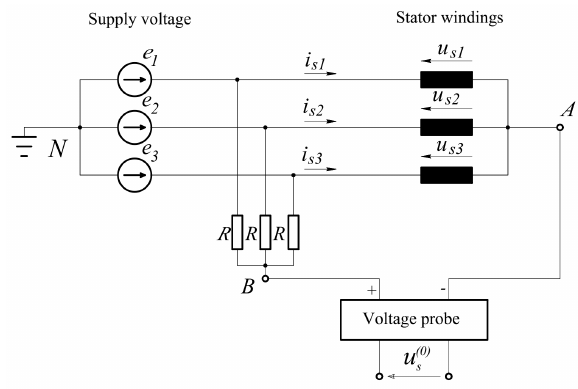
Figure 5. Equivalent circuit for the zero-sequence current component at the wye stator winding connection with the neutral wire.